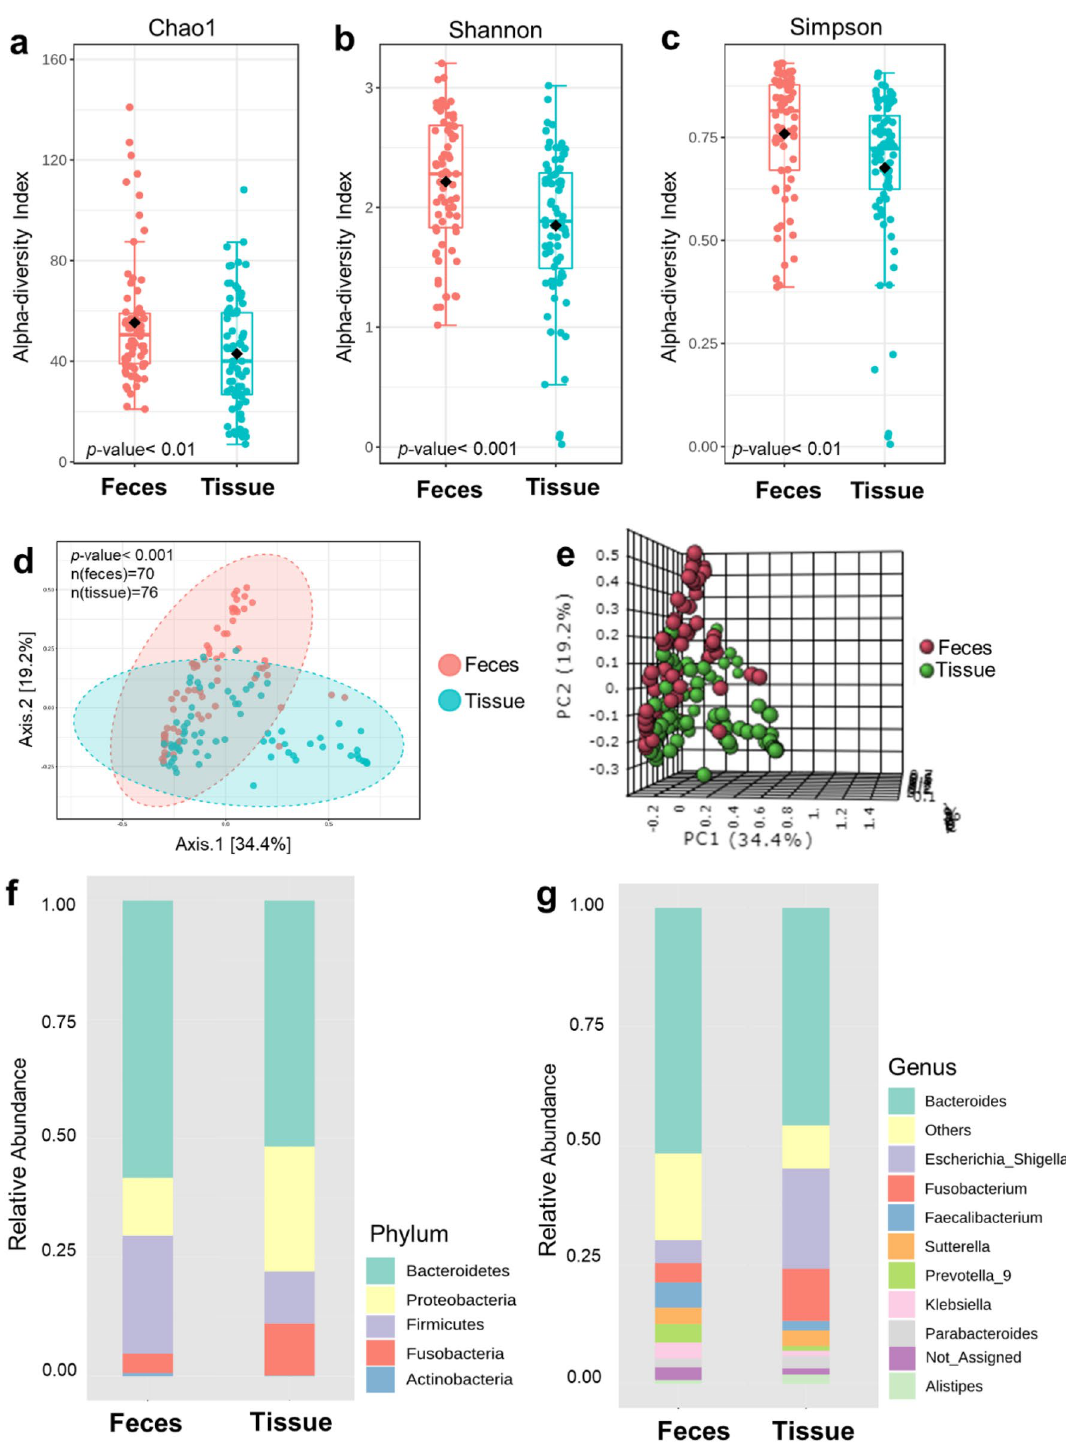
Figure 4. Microbial diversity analyses and microbial abundance profiling between feces and mucosal tissue samples, ( a ) Chao1’s index, ( b ) Shannon’s index, ( c ) Simpson’s index, ( d ) Principal Coordinate Analysis (PCoA) analysis based on Bray–Curtis distance in 2–Dimension, ( e ) PCoA analysis based on Bray–Curtis distance in 3– Dimension, (f ) Taxonomic composition type at the phylum level, ( g ) Taxonomic composition at the genus